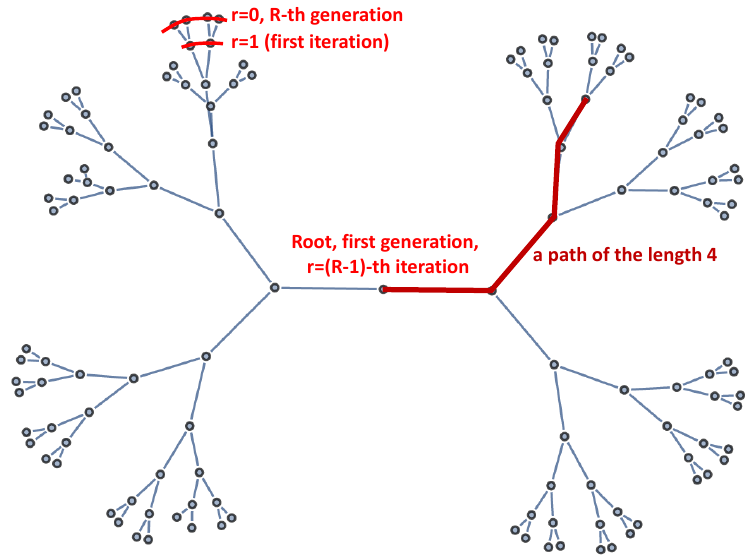
Figure 2: Cayley tree with K = 2. Iterations start from the boundary ( R th generation). The root (first generation) corresponds to ( R − 1 ) iterations. A path between the root and a point at a distance 4 is also